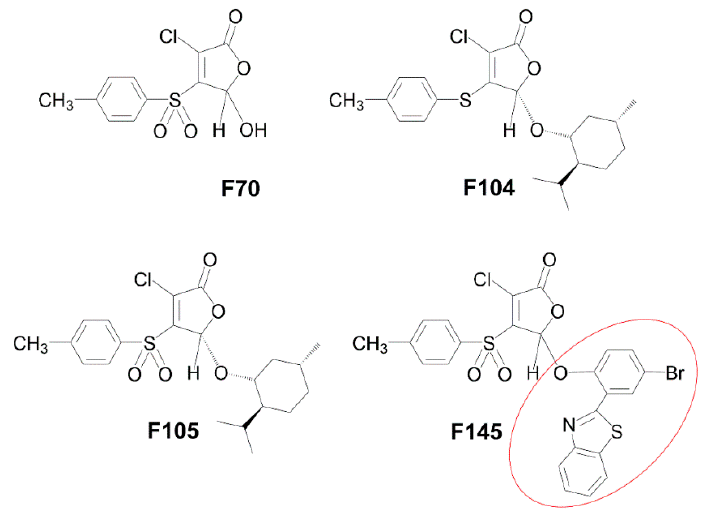
Figure 1. Molecular structures of 2(5 H )-furanone derivatives F70 [25], F104 [17], F105 [17], and F145 [26]. The red circle in the structure of F145 indicates a fluorescent 2-(benzothiazol-2-yl)-4-bromophenol (BTBP)